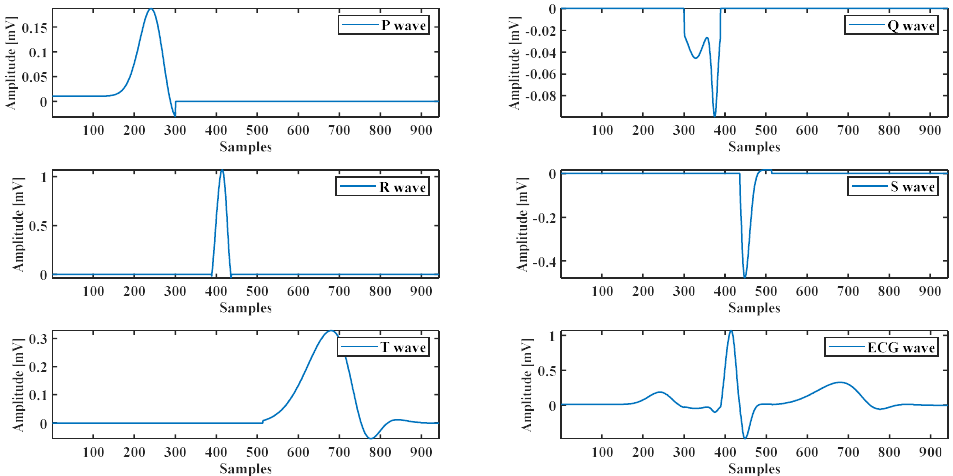
Figure 4. ECG components and a complete ECG signal.